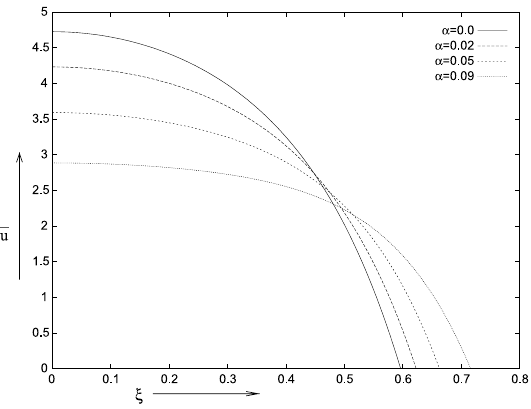
Fig. 5. Variation of axial velocity at z = 2 . 0 for different values of α , when H = 0 . 2, M = 2 . 5, β = 2 . 5, and k = 0 . 25.